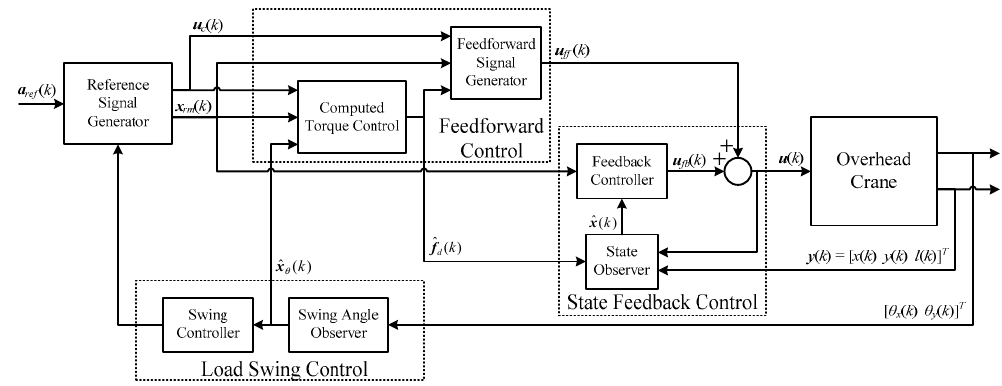
Figure 3. Configuration of the proposed control system for 3D overhead crane [53].